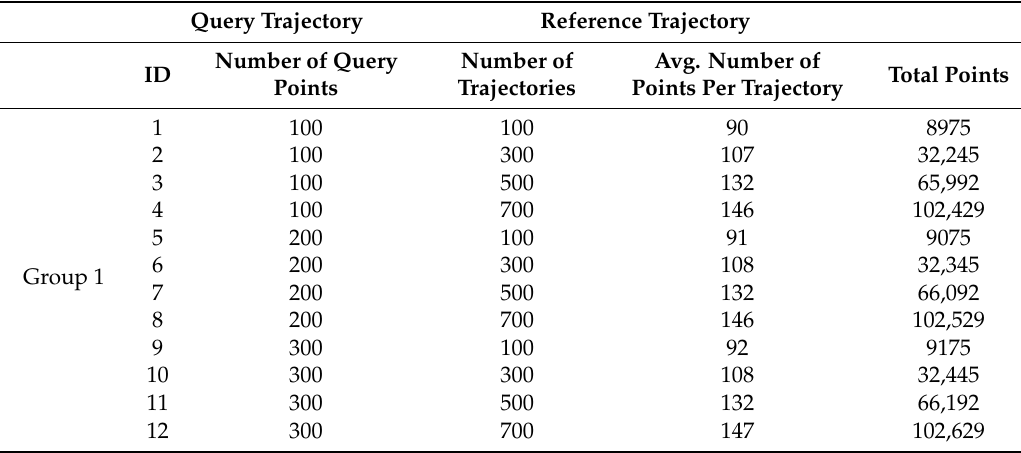
Table A1. Group 1